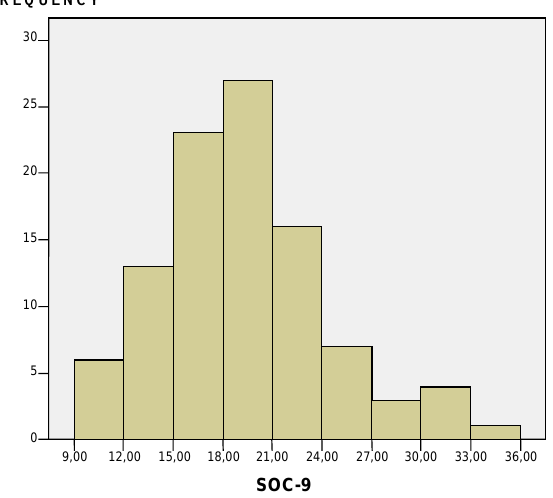
FIGURE 1. Distribution of respondents according to SOC.